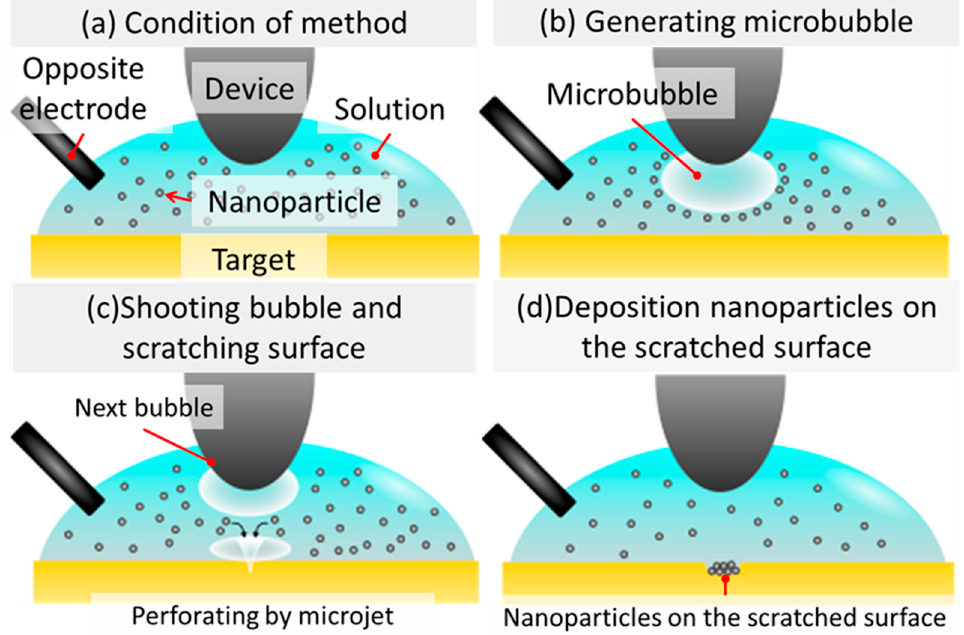
Figure 4. Concept and process flow of the presented method. ( a ) The bubble injector and opposite electrode were inserted into the solution, and the nanoparticles were dispersed in the solution. ( b ) Pulsed voltage was applied to the device, and a microbubble was generated in the solution. ( c ) The generated bubble was shot and scratched the surface of the target. ( d ) The nanoparticles were deposited and adhered to the part of the scratched surface of the target.